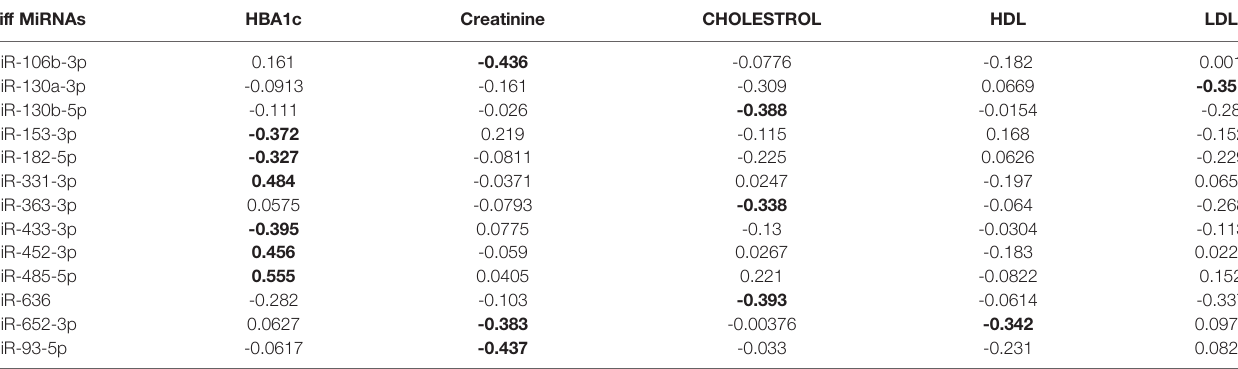
The bold values represent strong correlations i.e. |correlation| > 0.3.